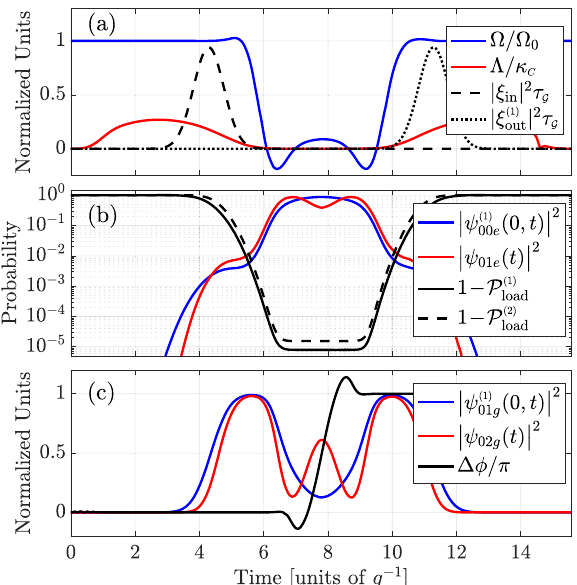
Fig. 4 Example of gate dynamics. a Control functions, Λ ( t ) and Ω ( t ) as a function of time along with the input wave packet and ideal one-photon output wave packet, ξ ð 1 Þ out . b Probability amplitude of the 0 ; t Þ , and the TLE being excited for a one-photon input, ψ ð 1 Þ 00 e ð ^ b and an excited TLE for probability amplitude of a photon in mode a two-photon input, ψ 01 e ( t ). The black curves plot the probability of having absorbed all the input photons [de fi ned in Eq. (23)] for a one- (solid) and two-photon input state (dashed). c Probability that all ^ b for a one- (blue) and two-photon input input photons are in mode state (red) along with the phase difference between the amplitudes of the corresponding Scrödinger coef fi cients [de fi ned in Eq. (22)] (black). Simulation parameters: κ C ¼ 6 Ω G , κ l = γ e = 0, g ¼ 0 : 4 Ω G , = 15 g , T = 4.3/ g , and T = 7/ g . Ω 0 in